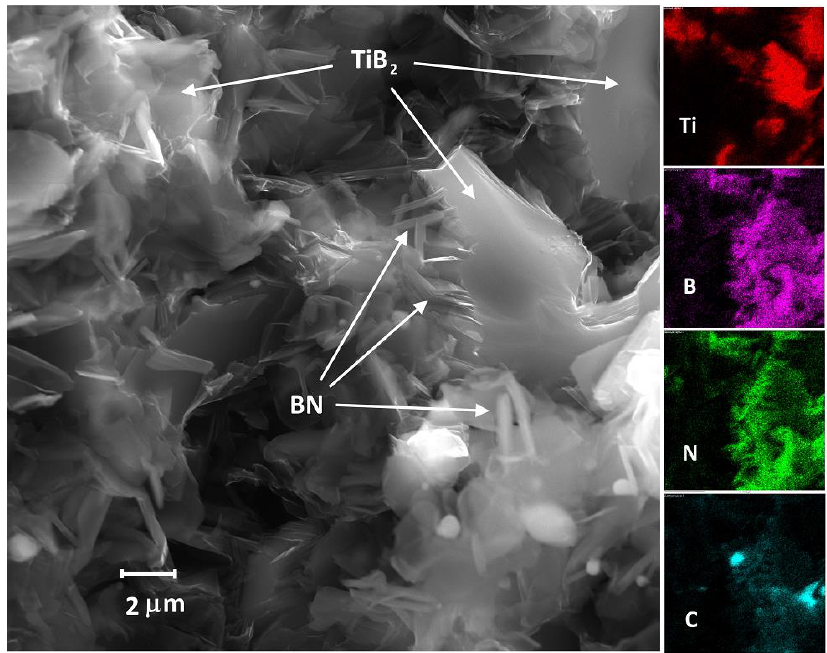
Figure 5. SEM (secondary electrons) and EDS elemental maps of the fractured TiB 2 -BN-C surface when the sample is hot pressed from TiN-B 4 C green body at 1900 °С.